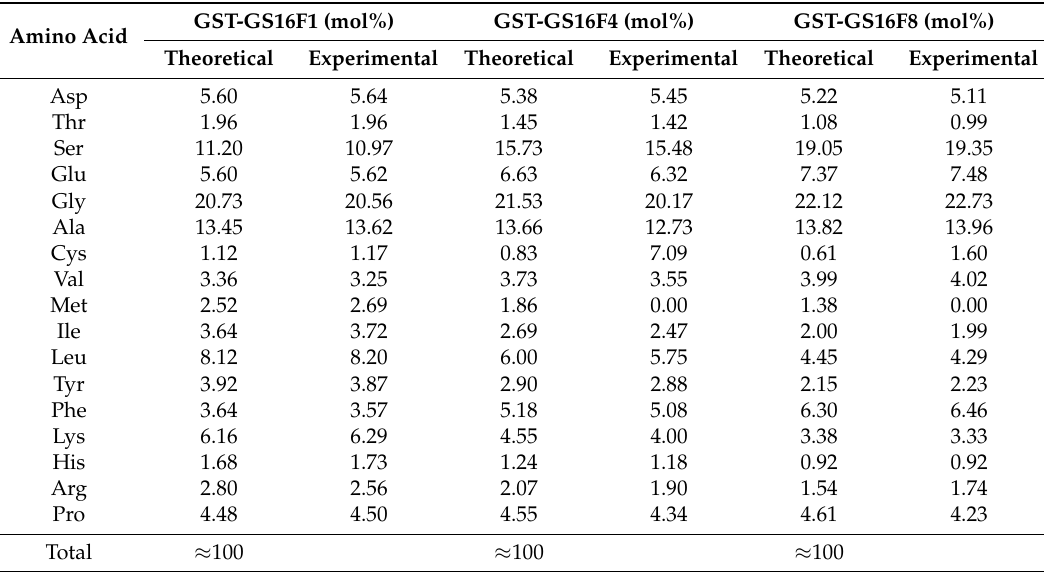
Table 1. Amino acid composition of three fusion proteins.